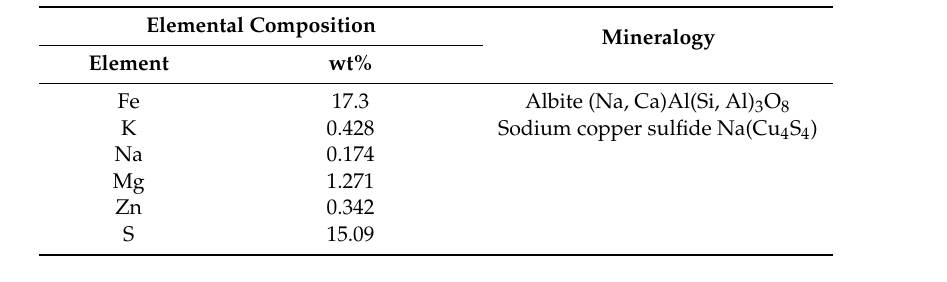
Table 2. Physical properties of